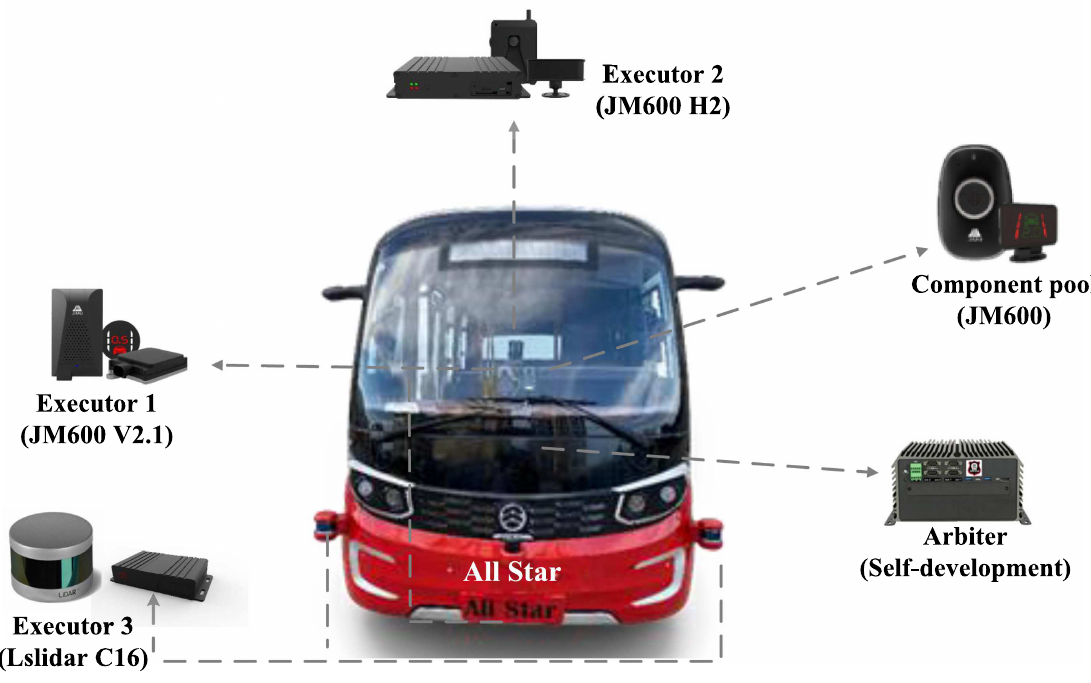
Figure 5. DHR prototype for